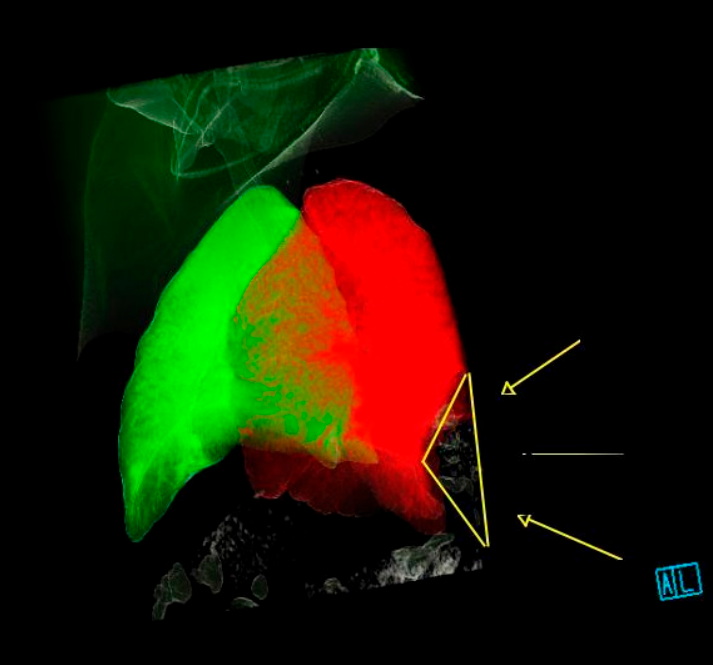
Figure 2 . 3-D reconstruction of the CT-scan performed in 2018 showing the location of the hernia (yellow arrows).